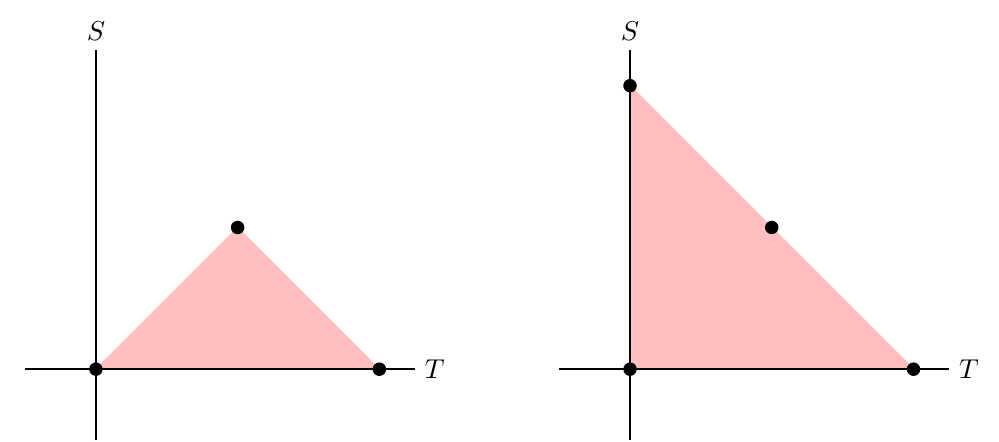
Figure 1. The Newton polytopes of the polynomials 1 + ST + T 2 (left) and 1 + S 2 + 2 ST + T 2 (right). Each black dot corresponds to a monomial, and the pink shaded area is their convex hull.